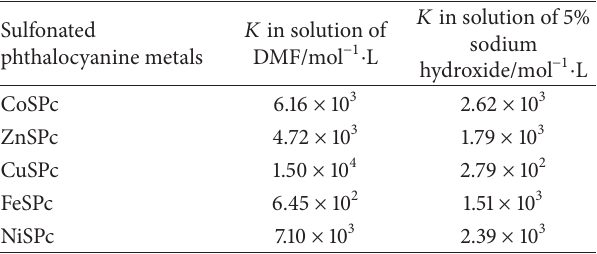
Table 3: Aggregation equilibrium constant 𝐾 of the five sulfonated phthalocyanine metals (30 ∘